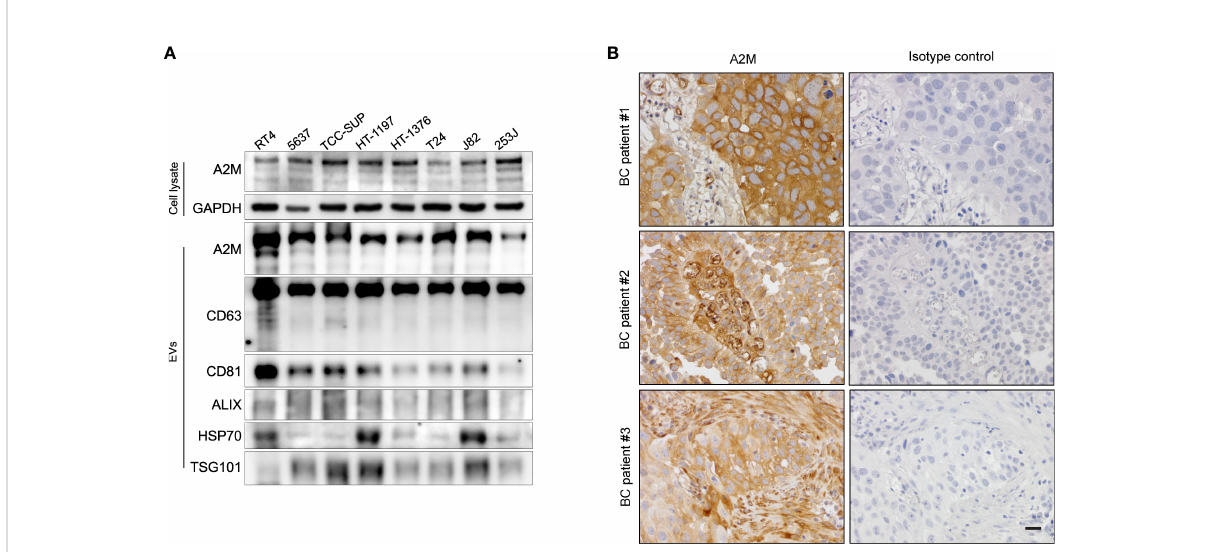
FIGURE 6 Expression of a2M in bladder cancer cell lines and tissues. (A) Western blot analysis of a2M in bladder cancer cell lines. (B) Immunohistochemistry for a2M in BC tissues. Representative a2M immunohistochemical images in BC tissues. a2M immunostaining showed high cytoplasmic expression in tumor cells with atypical larger nuclei of invasive urothelial carcinoma in BC patient #1. In BC patient #2, a2M expression exhibited a signi fi cant increase in the central fi brovascular core of the papillary tumor. a2M was expressed in the fi brous tumor stroma of BC patient #3. Right panel: Negative images using isotype control in bladder cancer tissues. Magni fi cation, ×400. Scale bars, 20 m